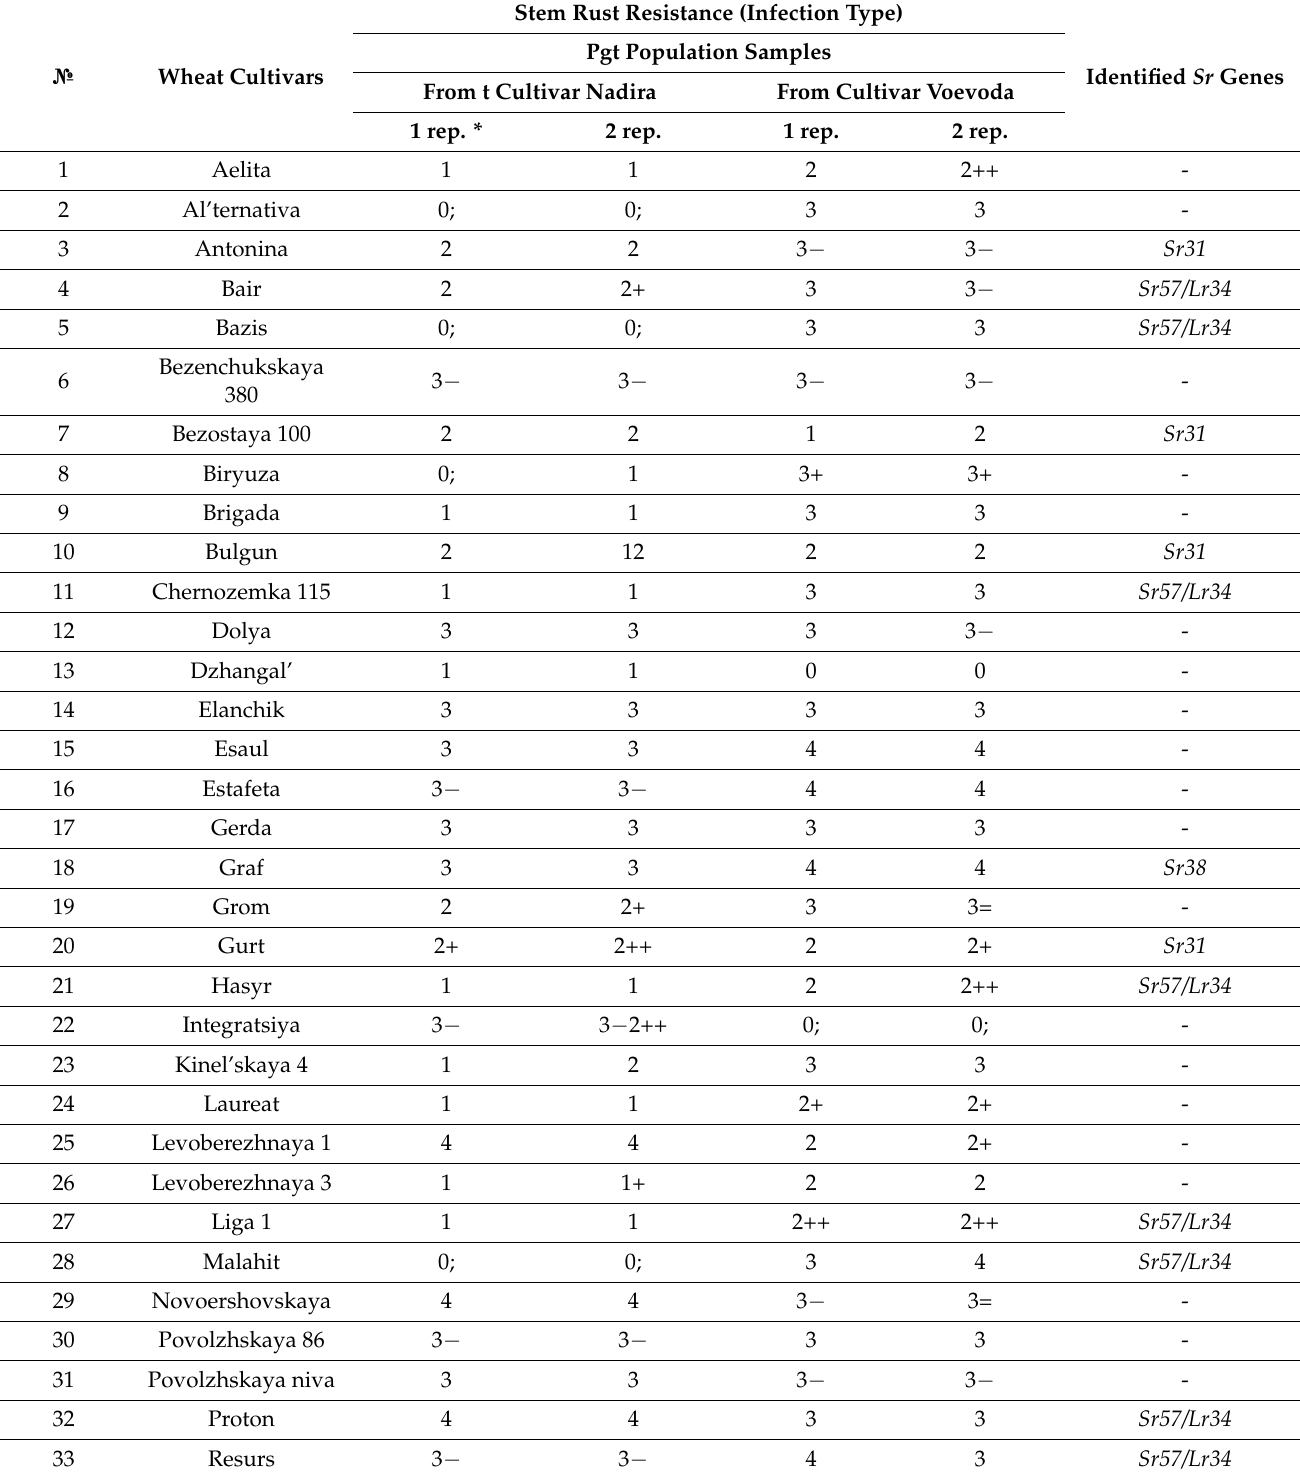
Table 4. Evaluation of resistance to stem rust and identification of Sr genes in winter bread wheat cultivars in the Volga